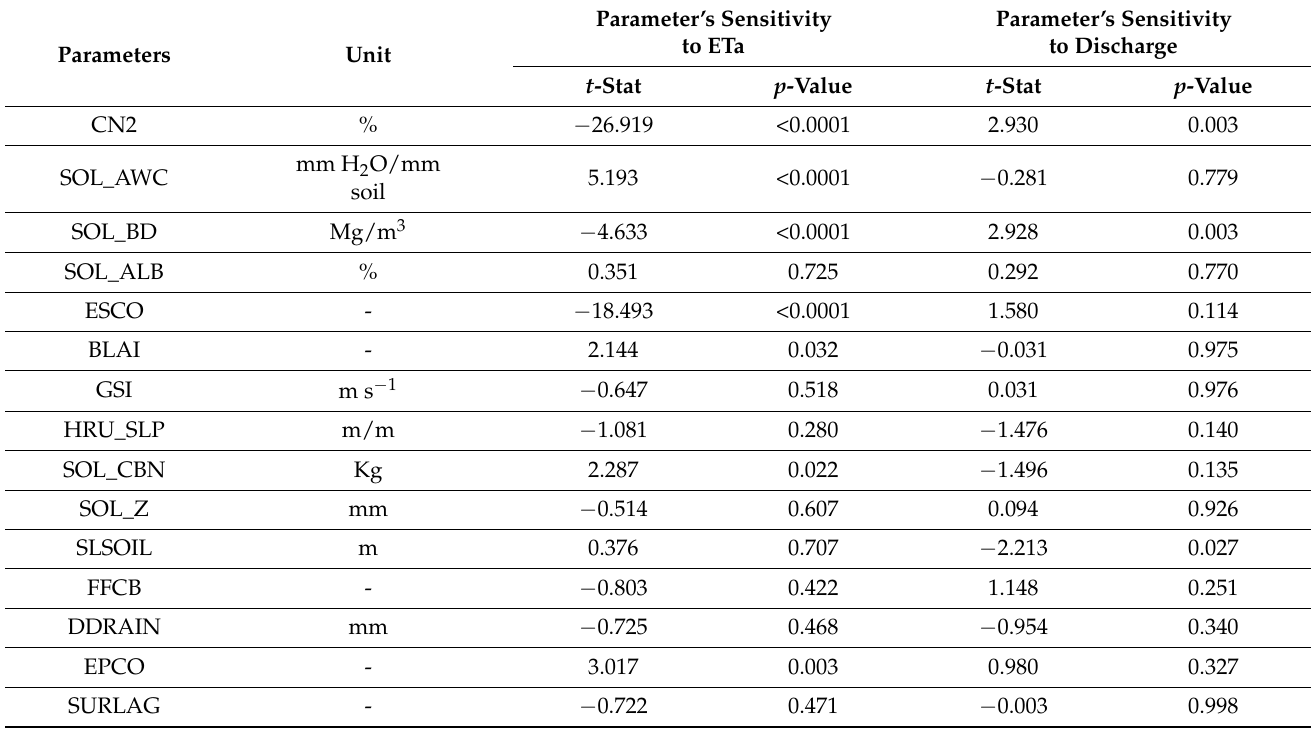
Table 7. Parameter sensitivity to ETa and discharge.